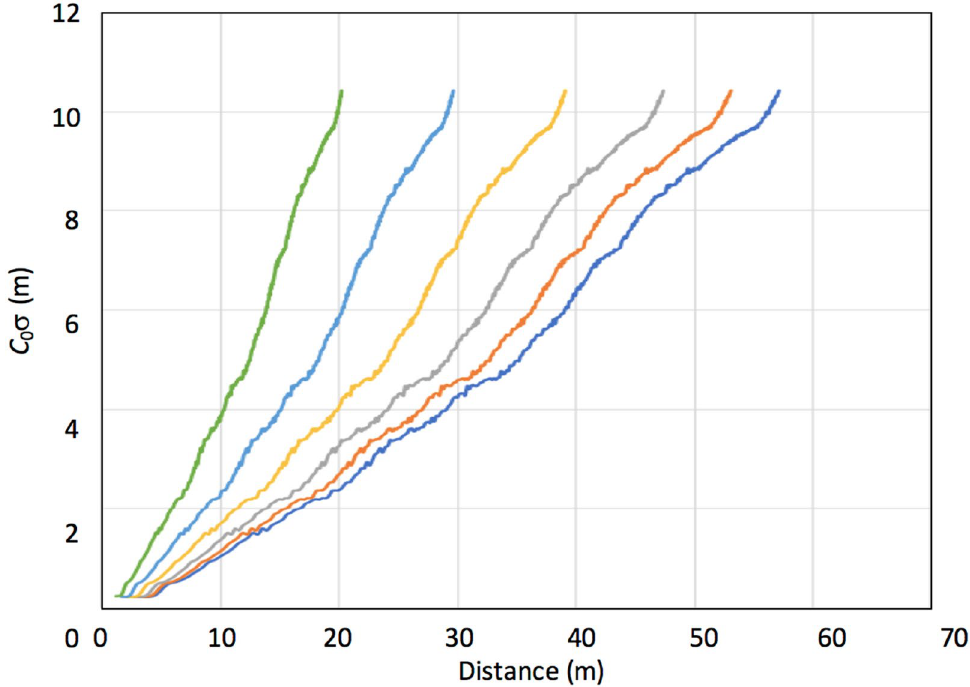
Figure 4. Measurement accuracy ( c 0 σ( t )) as a function of the maximum distance between the reference and receiver detectors for various muon arrival angles from horizon (green: 100 mrad; sky blue: 150 mrad; yellow: 200 mrad; gray: 250 mrad; red: 300 mrad; and blue: 350